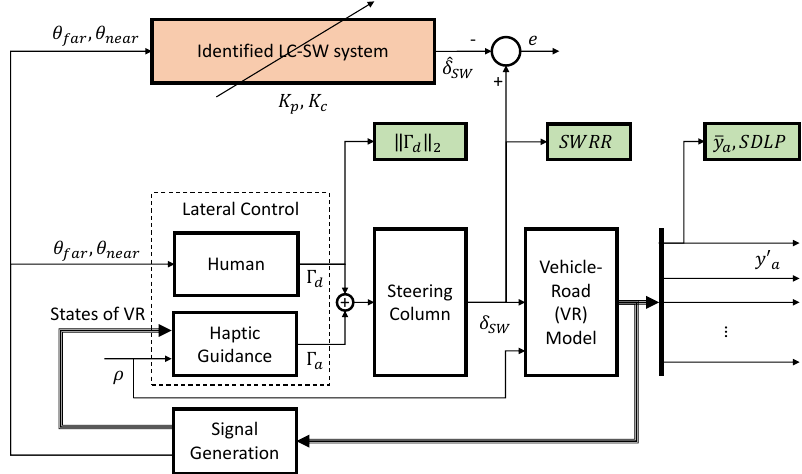
Figure 5. Summary of data analysis